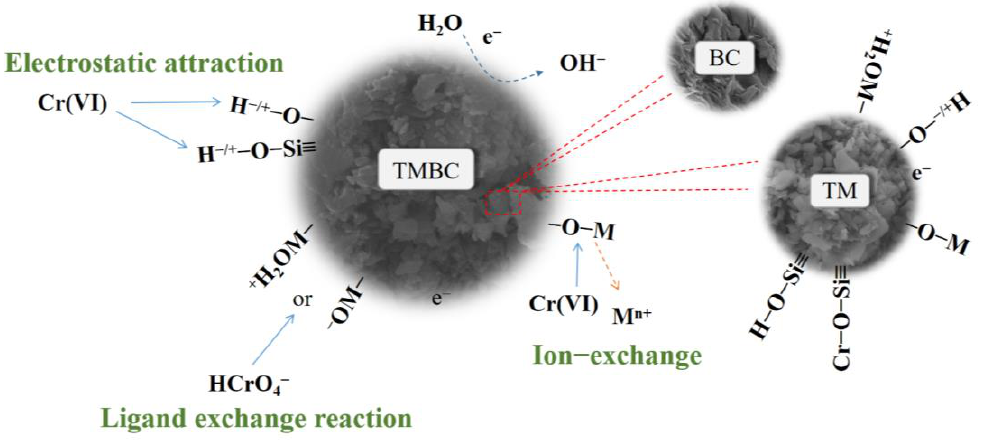
Figure 6. Adsorption mechanisms of Cr (VI) by TMBC.